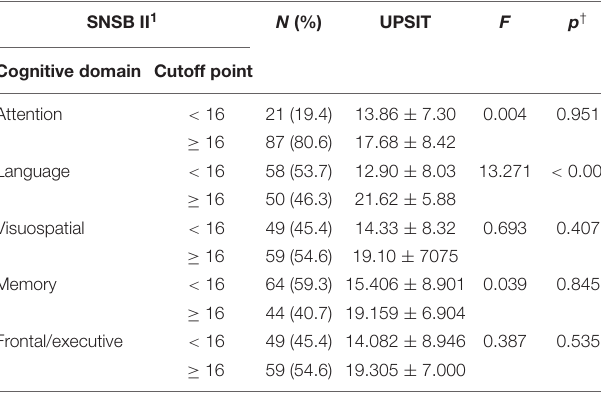
TABLE 4 | Differences in olfactory function according to cognitive function ( N =